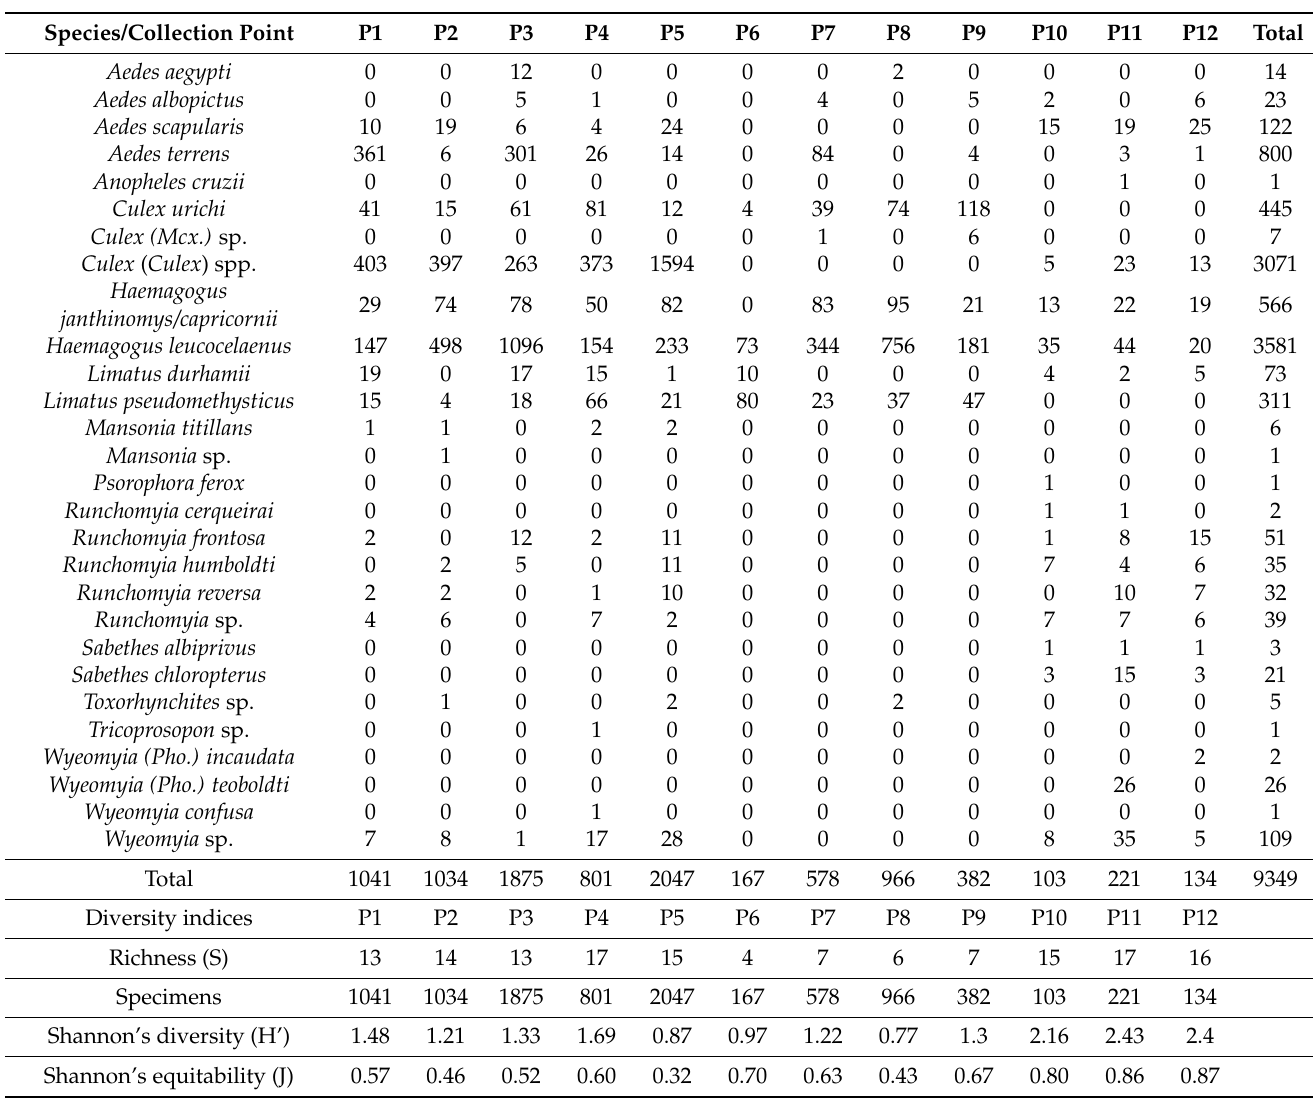
Table 4. Distribution, richness, diversity, and equitability of mosquito specimens obtained in the immature and adult collections at the Centro de Primatologia do Rio de Janeiro from December 2018 to December 2019 at 12 sampling